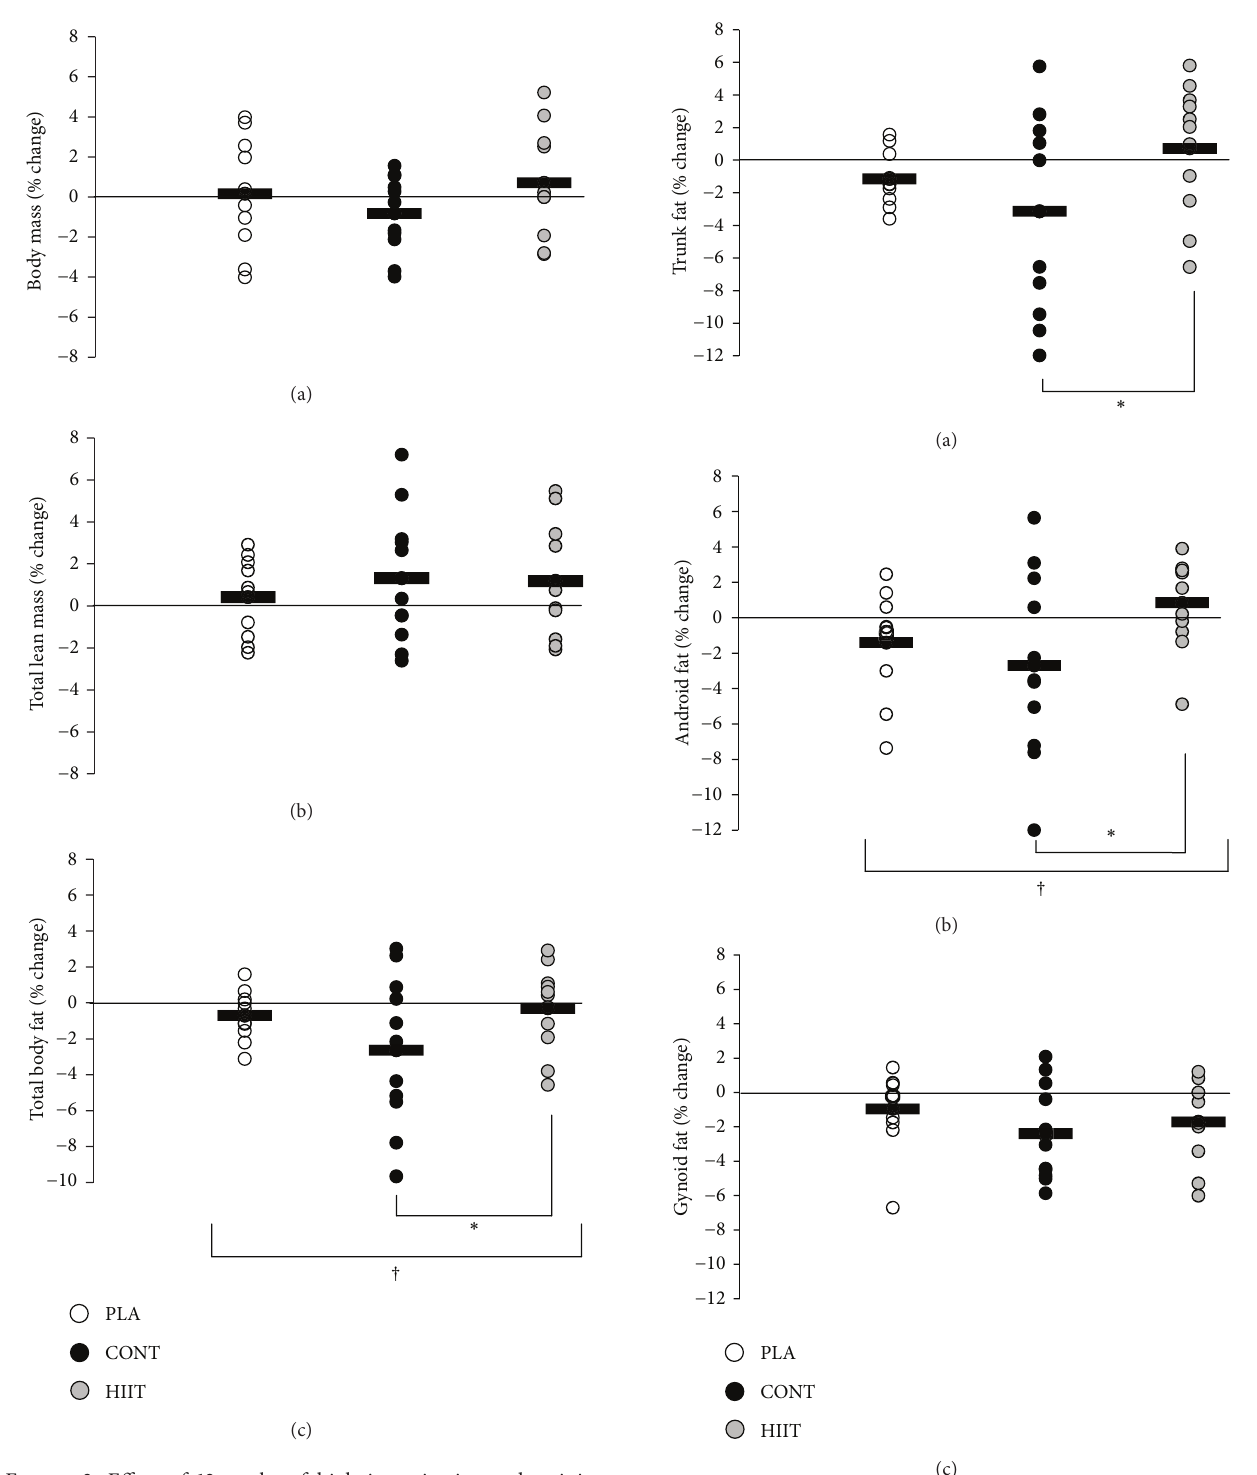
Figure 2: Effect of 12 weeks of high intensity interval training (HIIT) or continuous aerobic exercise (CONT) or control (PLA) on relative percent change in (a) body mass, (b) total lean mass, and (c) total body fat. Circles show individual percentage change from baseline and horizontal bars show mean group percentage change from baseline. Values are means ± SE; 𝑛 = 13 for HIIT, 𝑛 = 13 for CONT, and 𝑛 = 12 for PLA. † Significant treatment × time interaction ( 𝑃 < 0.05 ). ∗ Significant difference between CONT and HIIT ( 𝑃 < 0.05 ).